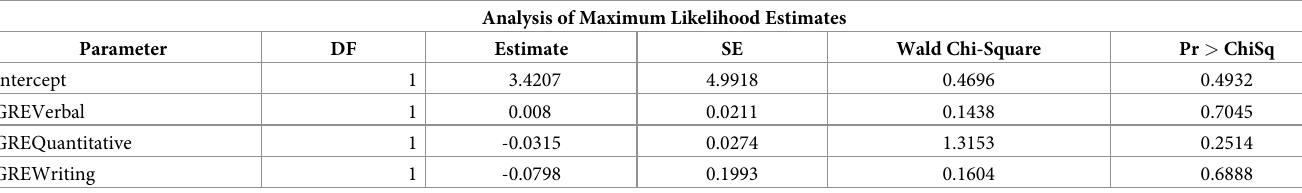
Table 4. Maximum likelihood estimates for drop out from ECE programs (N = 389).